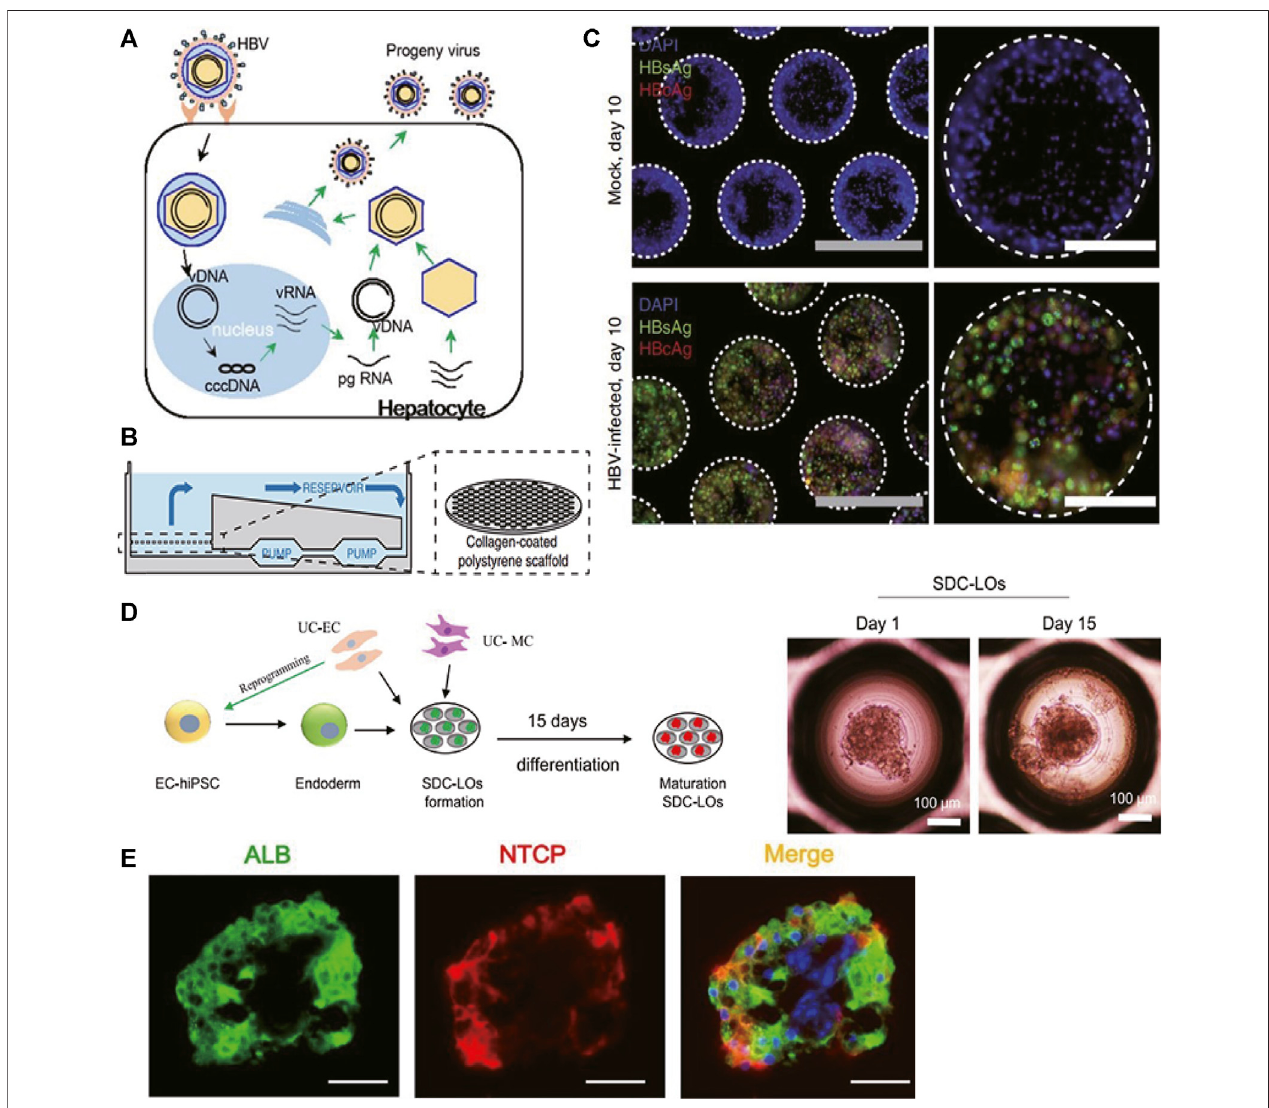
FIGURE 3 | Selected representative 3D models of viral hepatitis B. (A) Schematic representation of the HBV life cycle in infected hepatocytes. (B) Illustration of the PHH liver-on-a-chip model. Micro fl uidic recirculation was driven by a micro-pump and went through collagen-coated polystyrene scaffolds seeded with PHHs. (C) Immuno fl uorescenceofHBVviralantigens(HBsAgandHBcAg)10 daysfollowinginfection ofthePHHliver-on-a-chipmodelwithpatient-derived HBV(100GE/cell). (D) (Left)Schematicrepresentationoftheprotocolforliverorganoidgenerationanddifferentiationfromsingledonorumbilicalcord(UC)-derived hiPSCs,HUVECs,and mesenchymal cells (MCs). (Right) Morphology of single donor cell – derived liver organoids (SDC-LOs) on days 1 and 15. Scale bars, 100 μ m . (E) Immuno fl uorescence stainingofALBandNTCPindifferentiatedSDC-LOs.Green,ALB;red,NTCP. Scalebars,50 μ m . (A) Modi fi edwithpermissionfromYanetal.(2012). (B,C) Modi fi edwith permission from Ortega-Prieto et al. (2018). (D,E) Modi fi ed with permission from Nie et al. (2018).